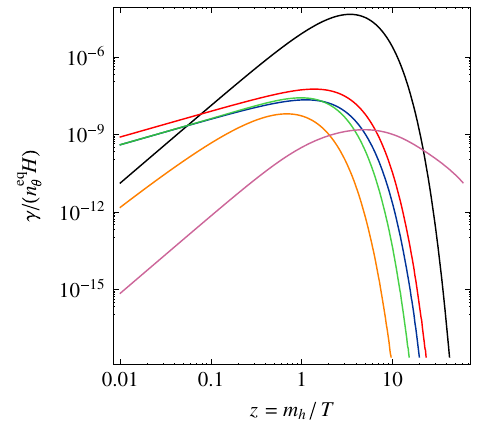
= ð n eq H Þ (black Dh (cid:1) =T and h